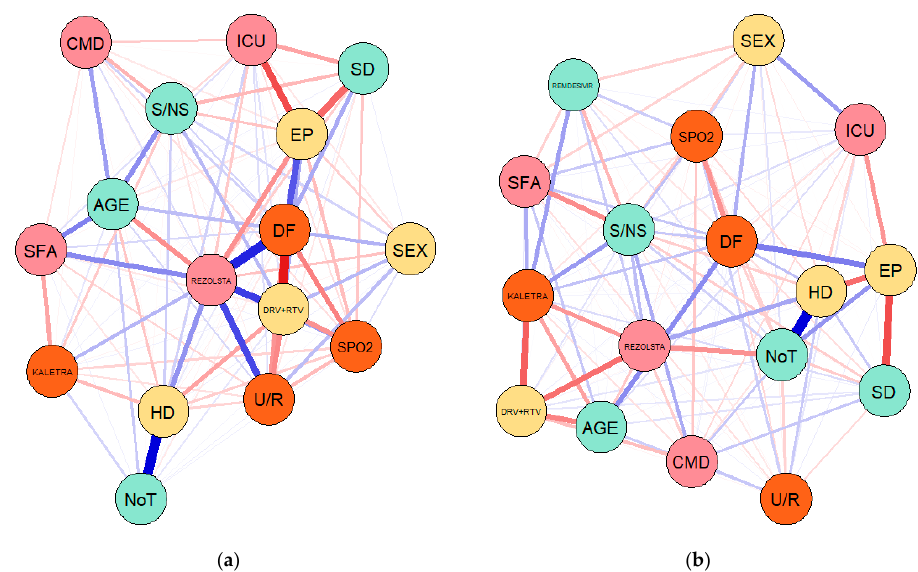
Figure 2. GGMs configuration through partial correlations method and the associated results: ( a ) first sample of 145 COVID-19 patients from the first wave of infection; ( b ) second sample of 129 COVID-19 patients from the second wave of infection. Source: Own configuration in RStudio version 3.6.3.